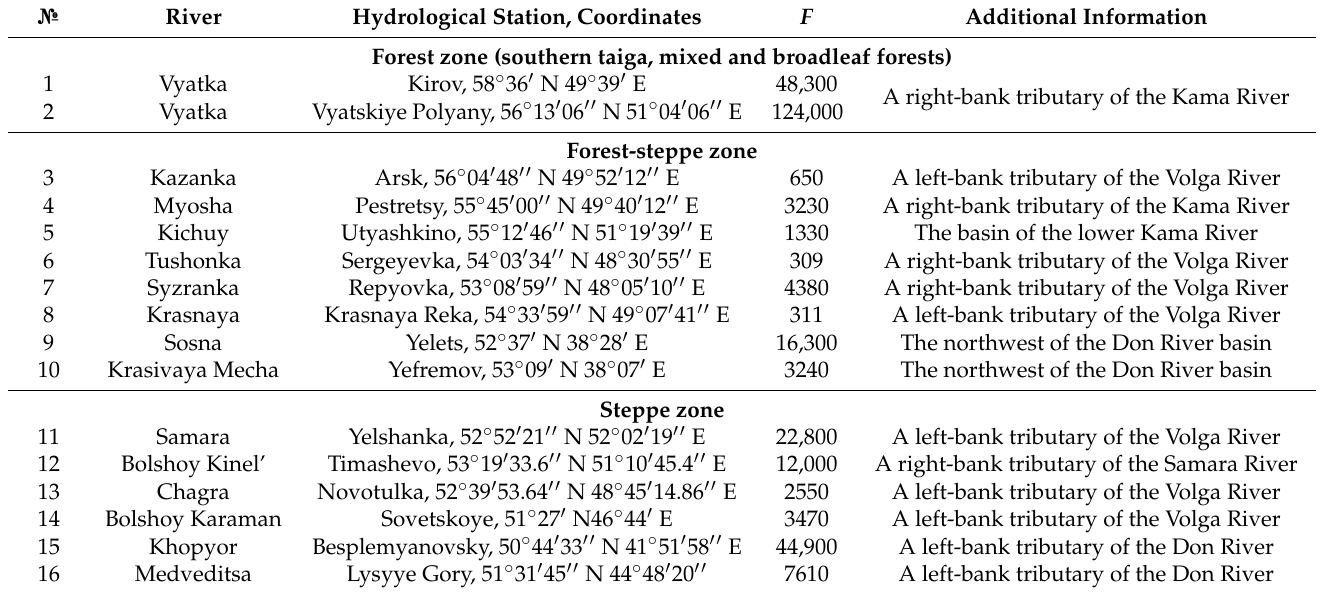
Table 1. The analyzed rivers (see Figure 2B); F –river basin area (km 2